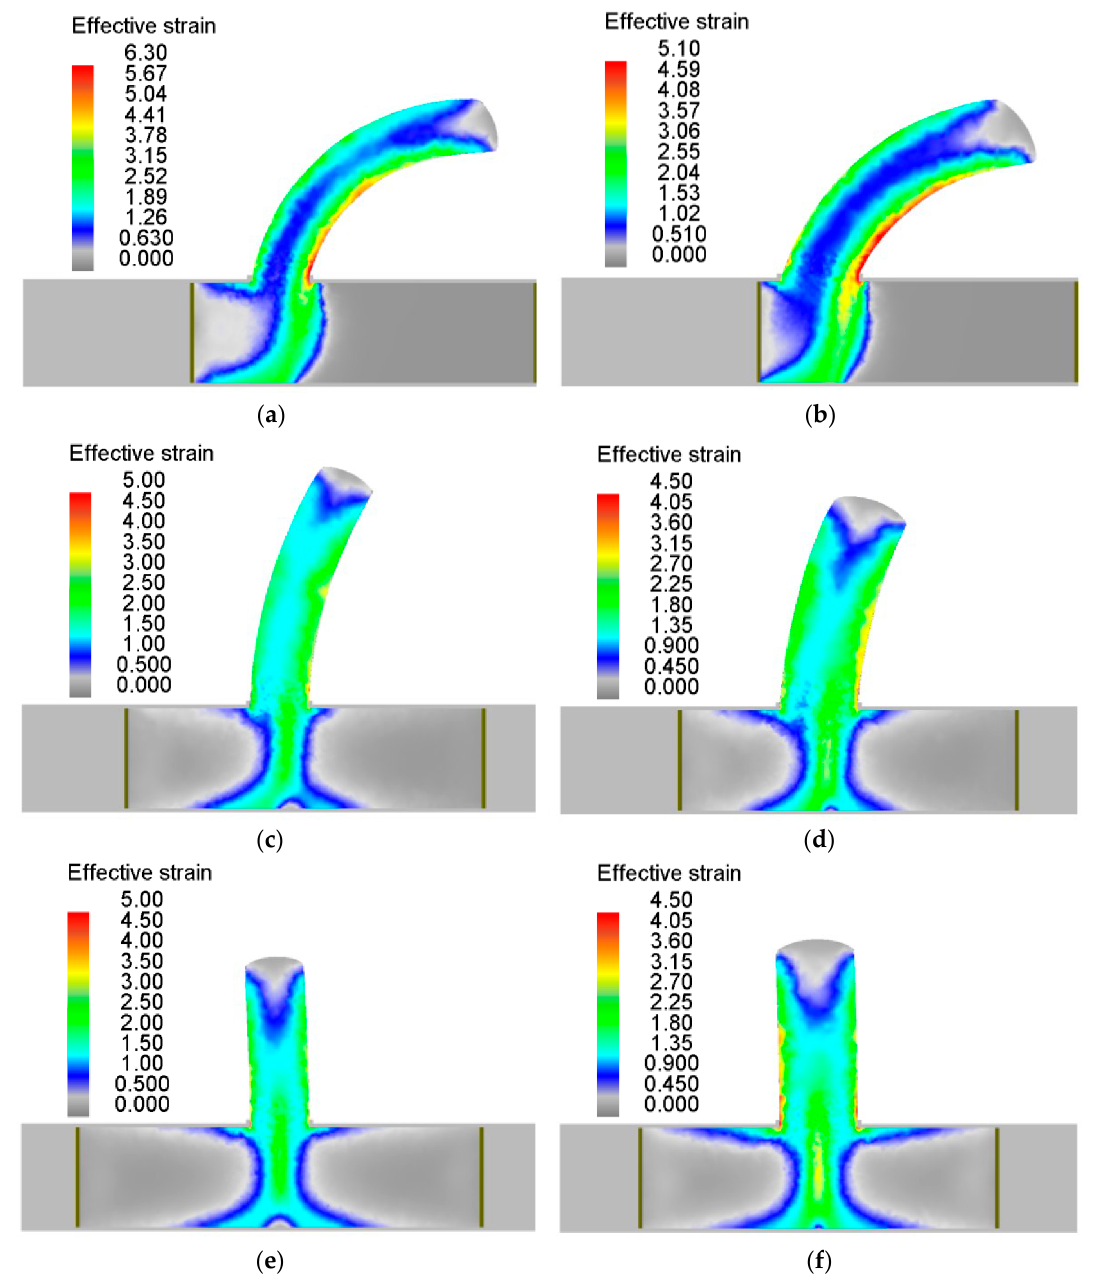
Figure 8. Simulated effective strain distribution at different extrusion ratios and velocity ratios: ( a ) v 2 / v 1 = 0, λ = 1.71, ( b ) v 2 / v 1 = 0, λ = 1.28, ( c ) v 2 / v 1 = 0.5, λ = 1.71, ( d ) v 2 / v 1 = 0.5, λ = 1.28, ( e ) v 2 / v 1 = 1, λ = 1.71 and ( f ) v 2 / v 1 = 1, λ = 1.28.